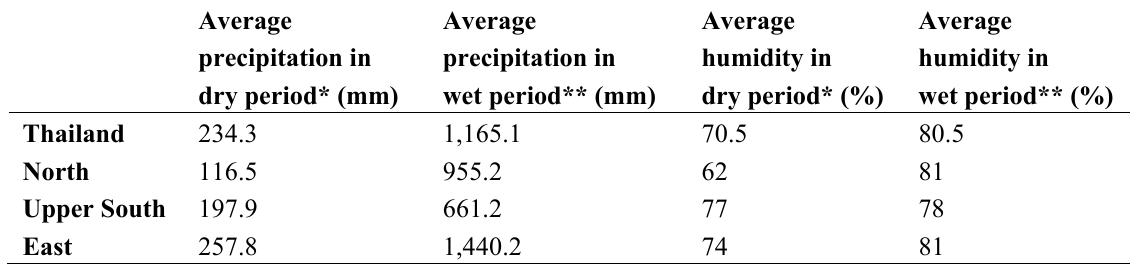
Table 1. Average precipitation and humidity of Thailand and the three validation test